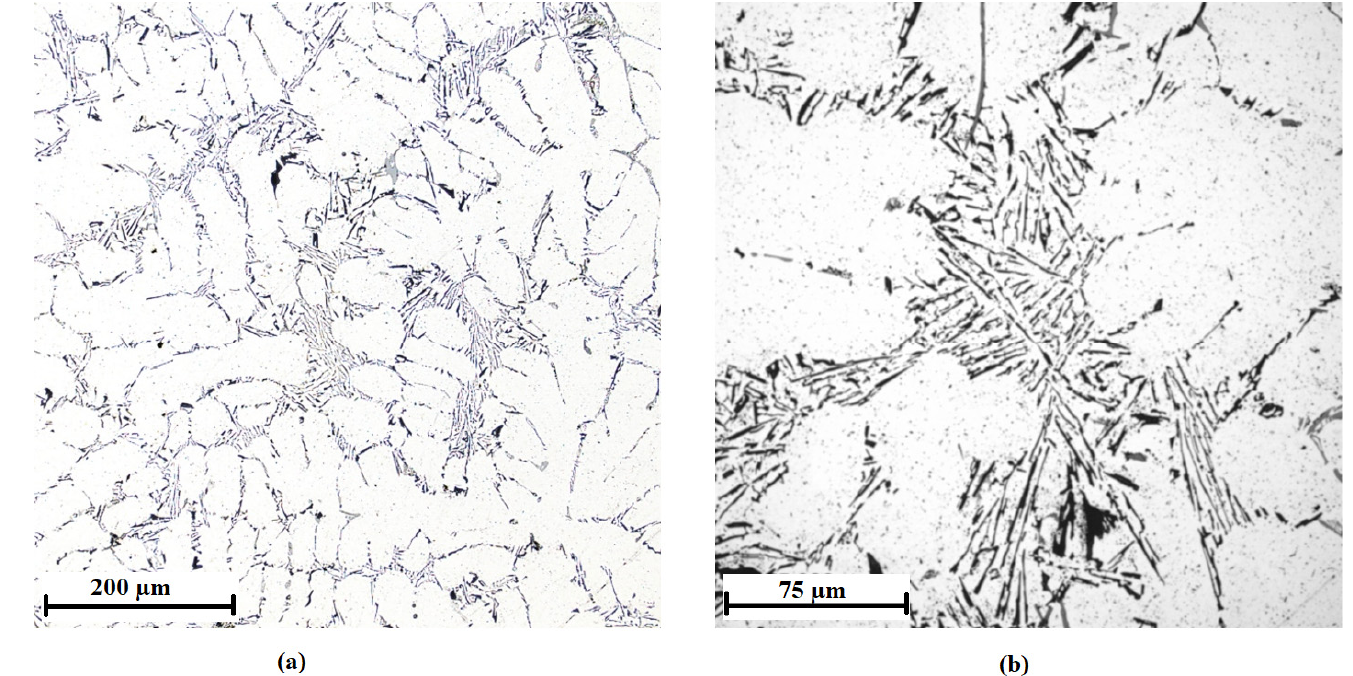
Figure 13. Microstructure of the AlSi7Mg0.3 alloy with the addition of 0.1 wt % AlTi5B1: ( a ) low- magnification overview, ( b ) detail.